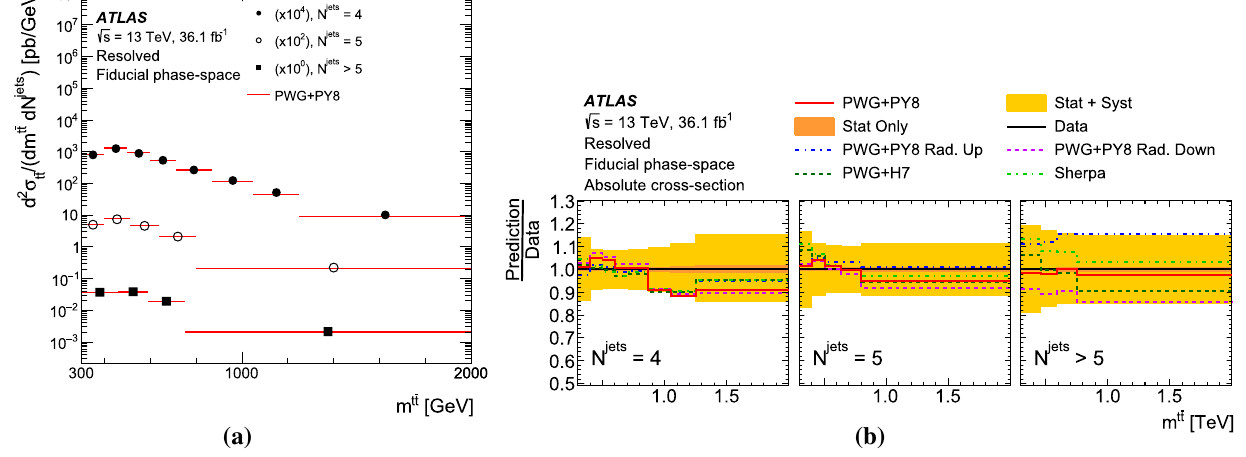
Fig. 31 a Particle-levelabsolutedifferentialcross-sectionasafunction of m t ¯ t in bins of the jet multiplicity in the resolved topology compared with the prediction obtained with the Powheg + Pythia8 MC genera-